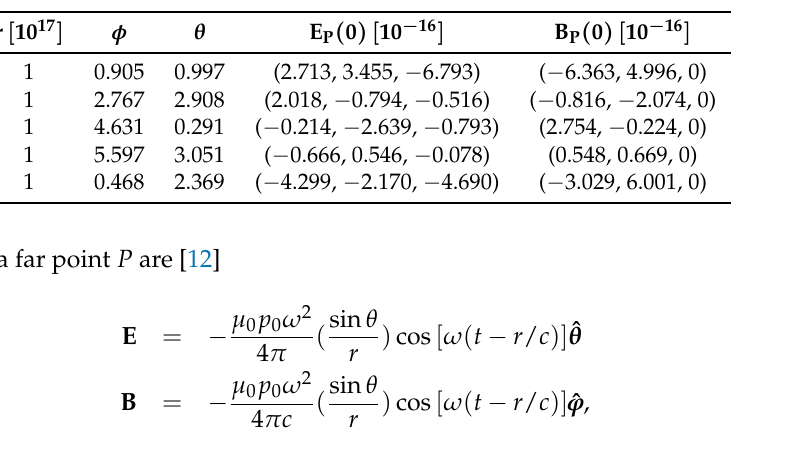
Figure 2. Geometry of the far-field of a dipole with moment p at the origin oscillating at angular frequency ω at a far point P . Table 2. Experiments with geometry parameters and the corresponding field observations at point P and time t ; adjusted for